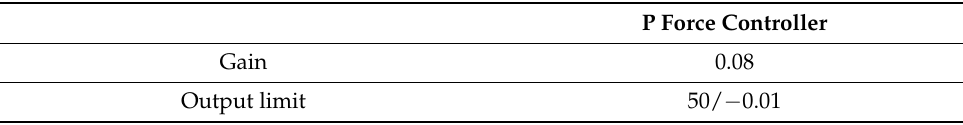
Table 2. Force controller parameters. Source: